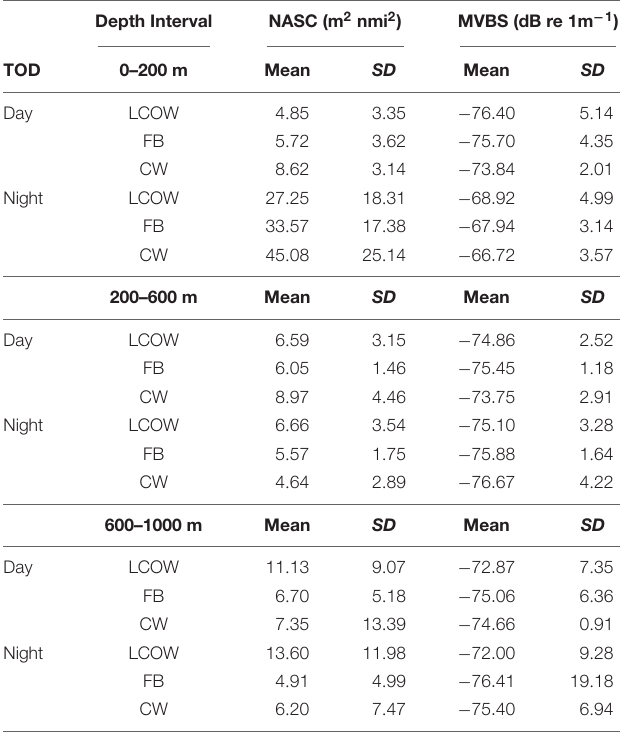
TABLE 1 | Mean acoustic backscatter by time of day (TOD) and oceanographic feature class (LCOW, Loop Current-origin water; FB, Frontal boundary; CW, Common